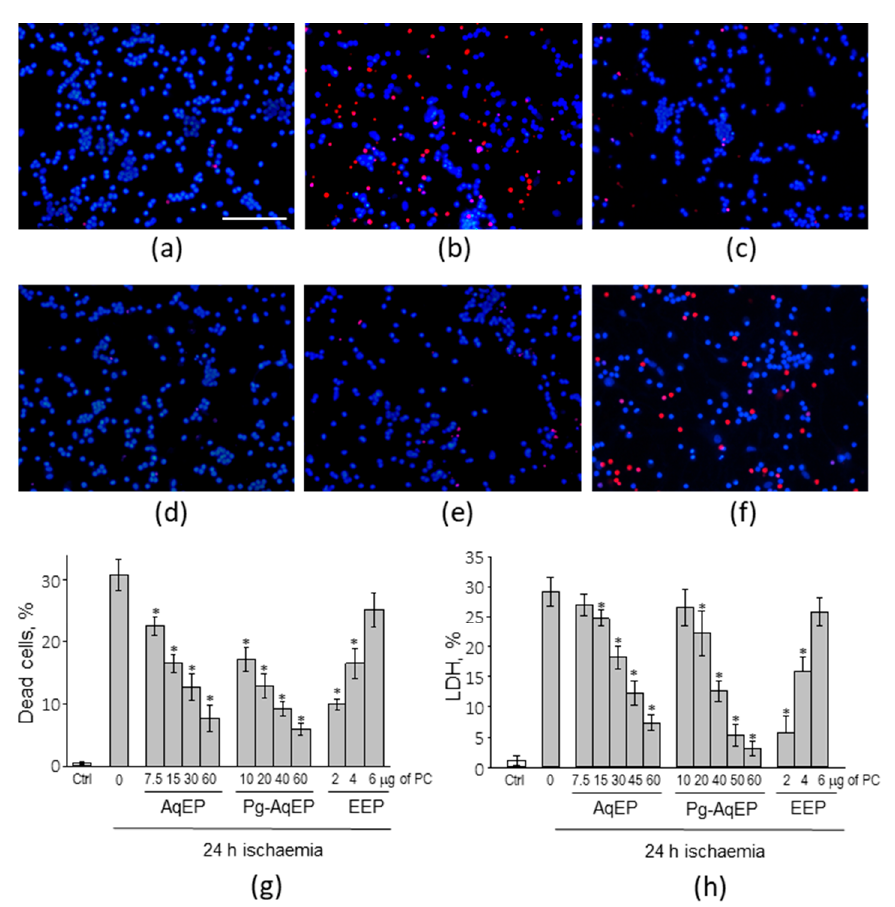
Figure 2. The e ff ect of the propolis extracts on simulated ischaemia (hypoxia plus DOG)-treated cerebellar cell viability. ( a – f ) Representative images of the double nuclear viability staining with Hoechst33342 and propidium iodide (PI). Blue nuclei indicate the cells have an intact nuclear membrane and are considered viable. Red, or PI-positive nuclei, are considered necrotic because of lost membrane integrity. ( a )—image of the control sample; ( b – f )—images of the hypoxia and deoxyglucose-treated samples, ( b )—without additional treatments, ( c )—together with 60 µ g / mL phenolic compounds AqEP, ( d ) – together with 60 µ g / mL phenolic compounds Pg-AqEP, ( e )—with 2 µ g / mL phenolic compounds EEP, and ( f )—with 6 µ g / mL phenolic compounds EEP. Scale bar is 100 µ m. ( g ) The percentage of dead cells per microscope image. Data are presented as an average ± SE of 3 experiments; 10 images of each sample were evaluated in each experimental set. ( h ) The percentage of total cellular LDH released to the cell culture medium during the treatment. Data are presented as an average ± SE of 3 experiments performed in triplicate. For both ( g ) and ( h ), *—statistically significant di ff erence compared with the hypoxic control (0), p < 0.05; all hypoxic samples were significantly di ff erent compared to the normoxic control, p < 0.001.